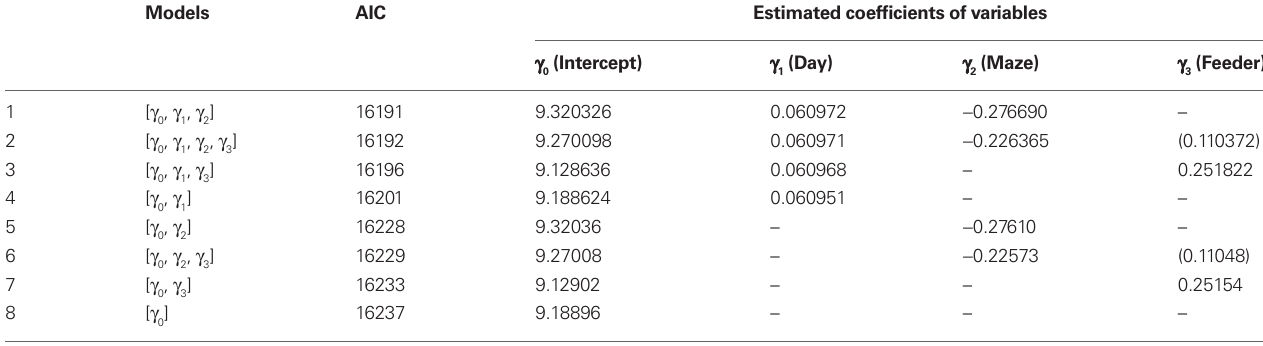
Table A3 | The day – maze model yielded the smallest AiC. Models